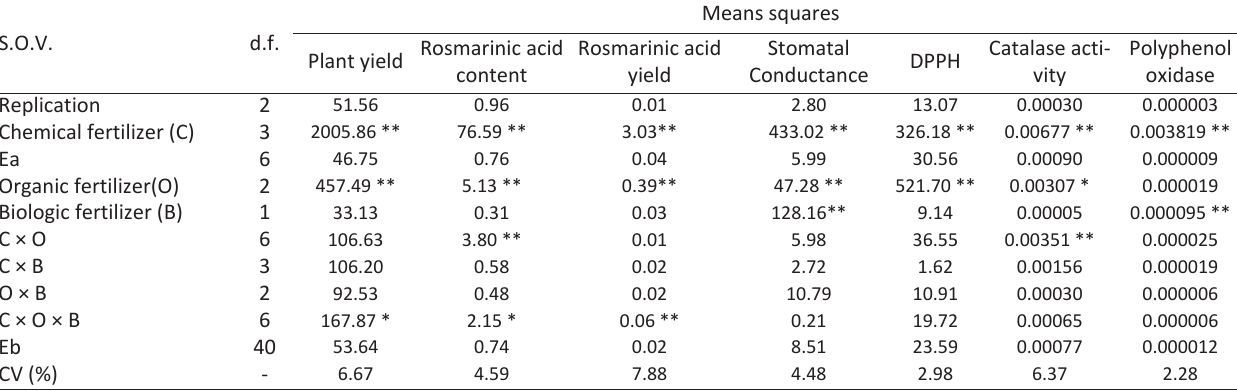
*, ** significant at 5% and 1% probability levels,